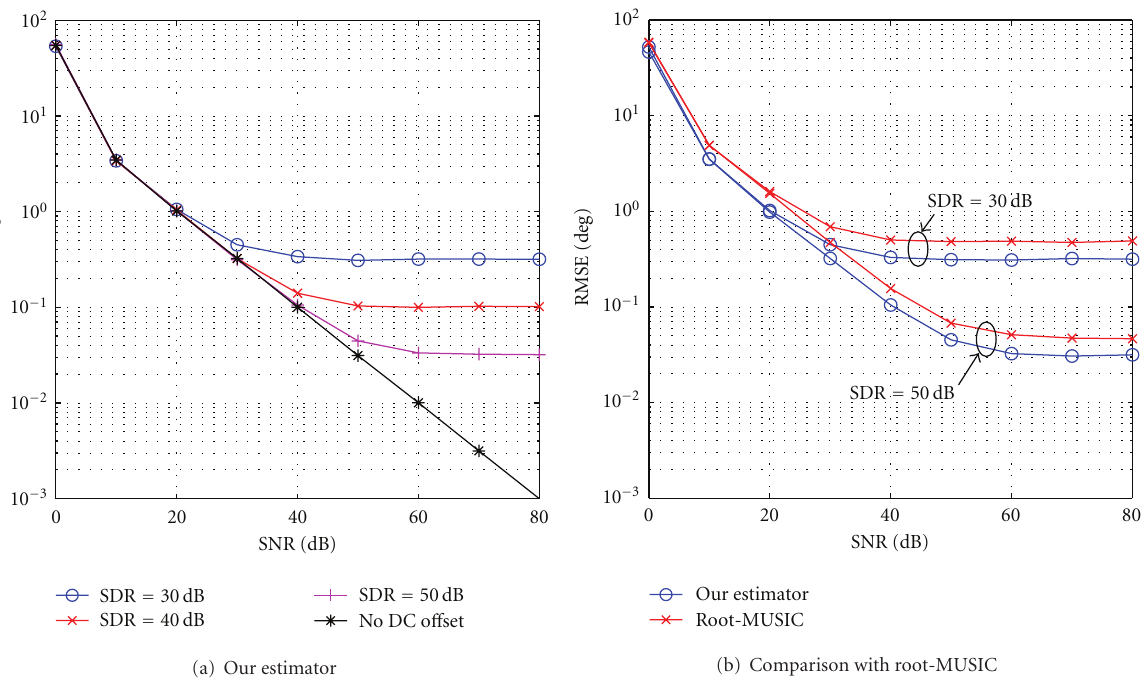
Figure 7: Aggregate RMSE as a function of SNR and SDR.